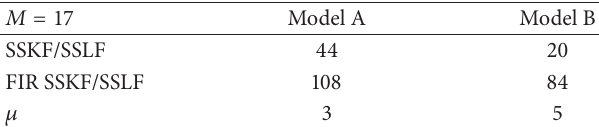
Table 7: FIR results for Example